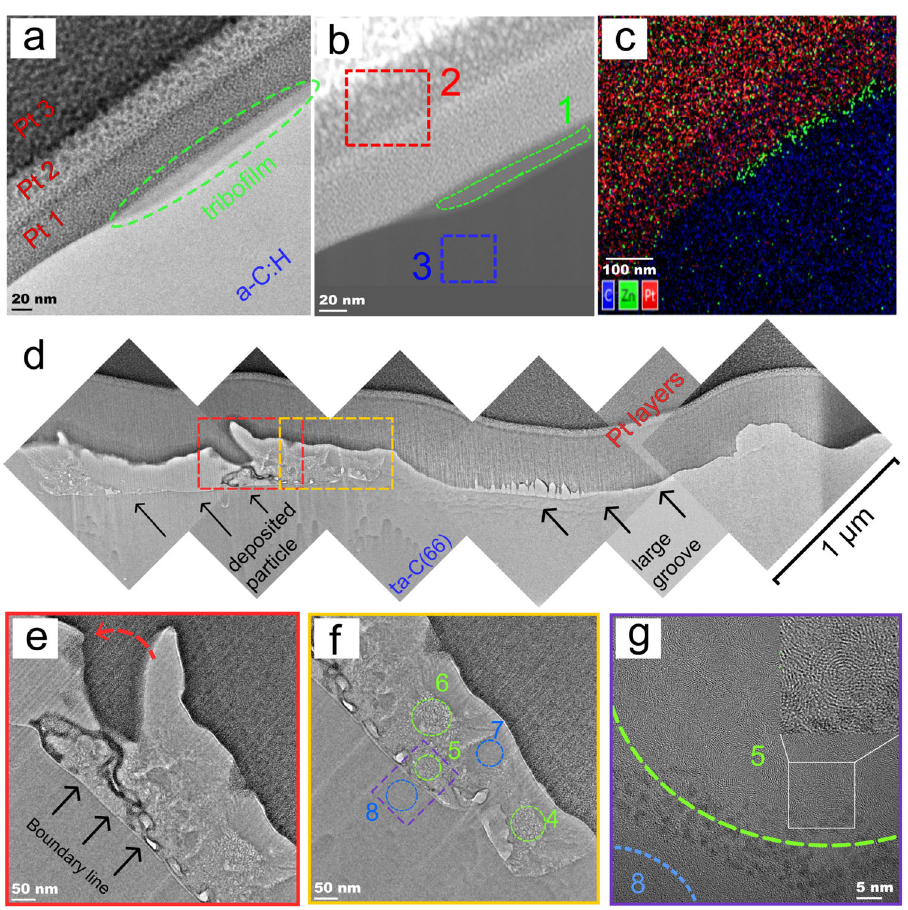
Fig. 4 Cross-sectional images of DLC surfaces after sliding. a BF TEM image of the cross section of a a-C:H surface. b HAADF image with recorded spectra from three different regions of interest (ROI). ROI 1: ZDDP-derived tribo fi lm, ROI 2: protective platinum layer, and ROI 3: a-C:H layer. c EDX map cartography superposition showing X-rays signal signatures of platinum (red), carbon (blue), and zinc (green). d Combined BF TEM images of the cross- section of a ta-C(66) surface. e , f TEM images of a boundary between the smeared layer of wear debris and ta-C bulk (indicated in d by the red and yellow box for e and f , respectively). In f , the ROIs used for EDX analysis are speci fi ed. g A high magni fi cation TEM image of wear particles smeared on the ta-C (66) surface (indicated by the purple box in f